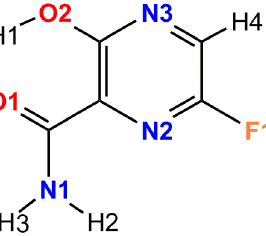
Table 1. Summary of the powder patterns depicted in Figure 1 refinement.